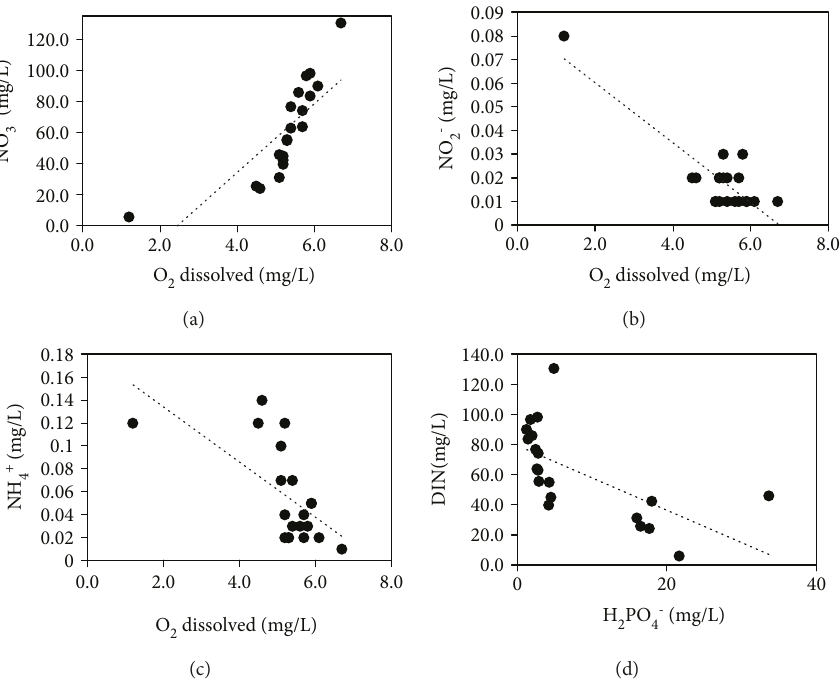
Figure 6: Bivariate plot of O